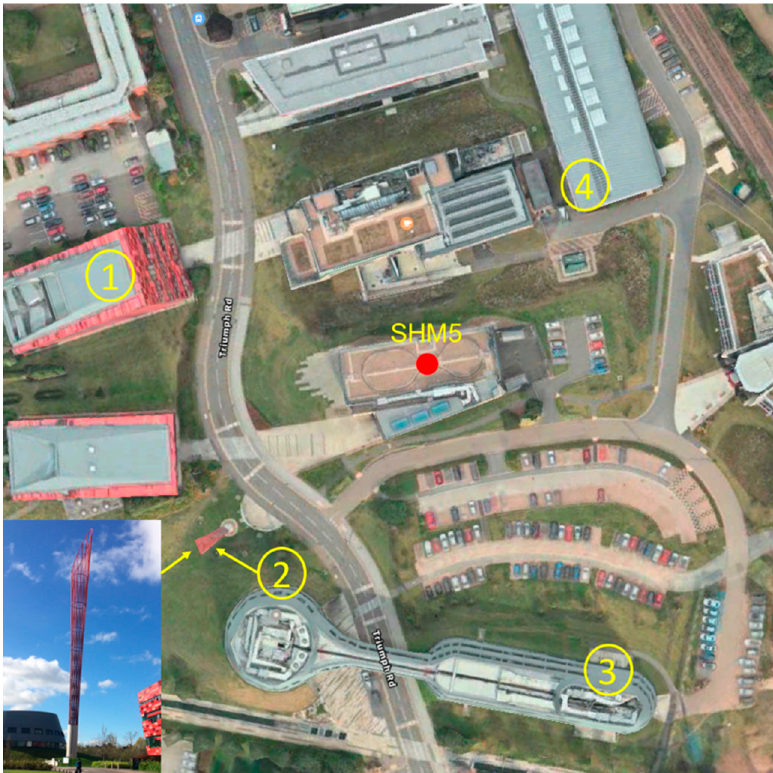
Figure 14. The observation environment for SHM5.